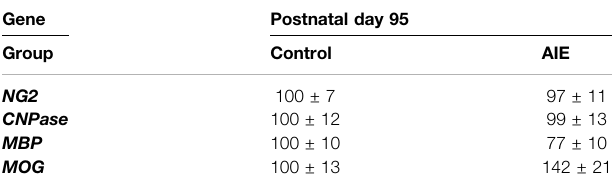
TABLE 3 | Effects of adolescent intermittent ethanol (AIE, 5 g/kg, i.g., 2 days on/ 2 days off) exposure on oligodendrocyte mRNA gene expression in the prefrontal cortex of male rat brain at P95.